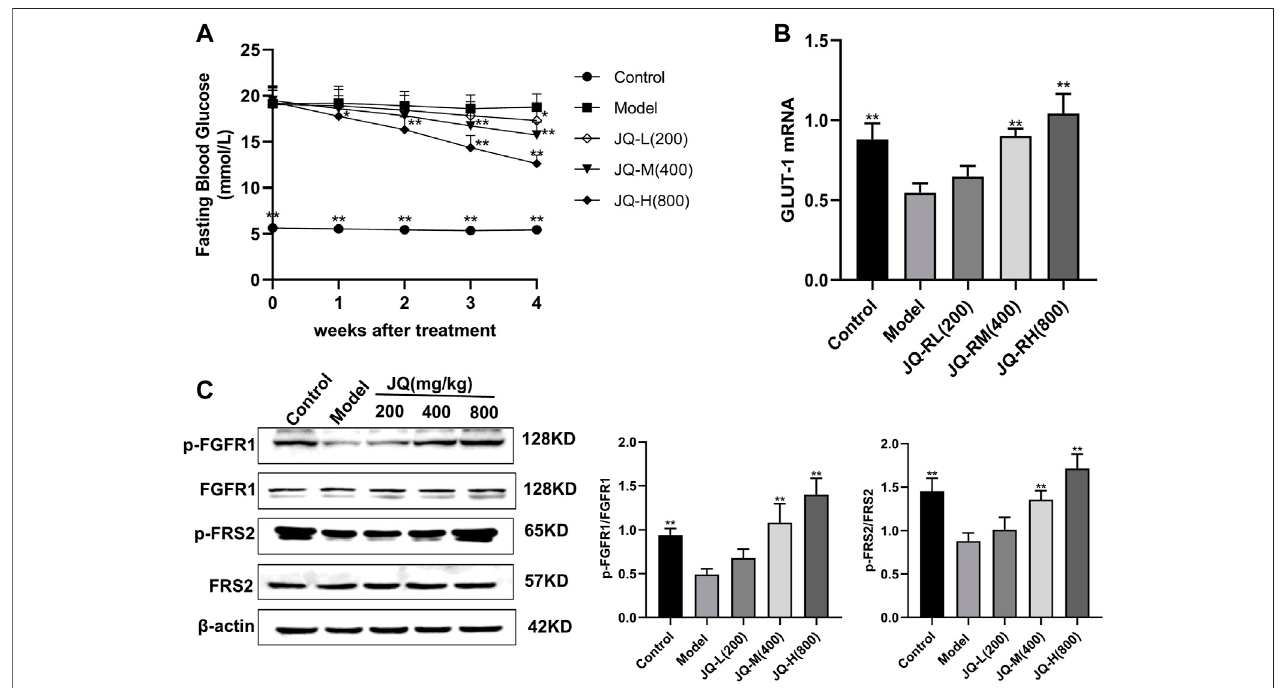
FIGURE 1 | The effect of JinQi Jiangtang tablet (JQJTT) on the fi broblast growth factor receptor 1 (FGFR1) pathway in mice with streptozotocin (STZ)-induced diabetes. (A) Thefastingbloodglucoselevelineachgroup. (B) TherelativemRNAlevelofglucosetransportertype1(GLUT-1)intheliversofmiceineachgroup. (C) The protein expression levels of p-FGFR1 and FGFR1 (p-FGFR1/total FGFR1) and those of p-FRS2 and FRS2 (and p-FRS2/total FRS2) as quanti fi ed using western blot. Data are presented as means ± SD, n = 12. * p < 0.05, ** p < 0.01, versus the model group.